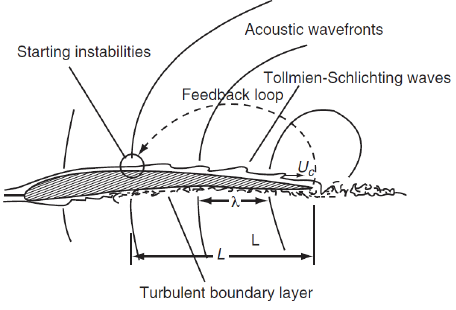
Figure 2. Feedback loop in airfoil flow-acoustic interaction (adapted from Longhouse [7]).